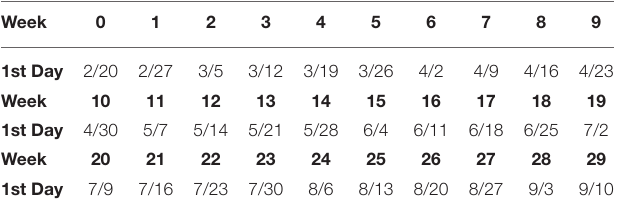
TABLE 2 | Date of the first day of each week. TABLE 3 | Frequency of severe cases and severe rate (%) by stage.